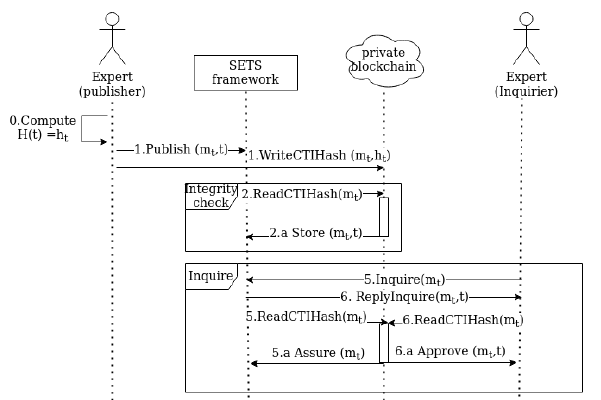
Figure 4. Sequence diagram of the SETS framework with respect to the request-response communica- tion paradigm. Each step in this communication model is shown using the given inputs and the step numbers specified in Figure 1.